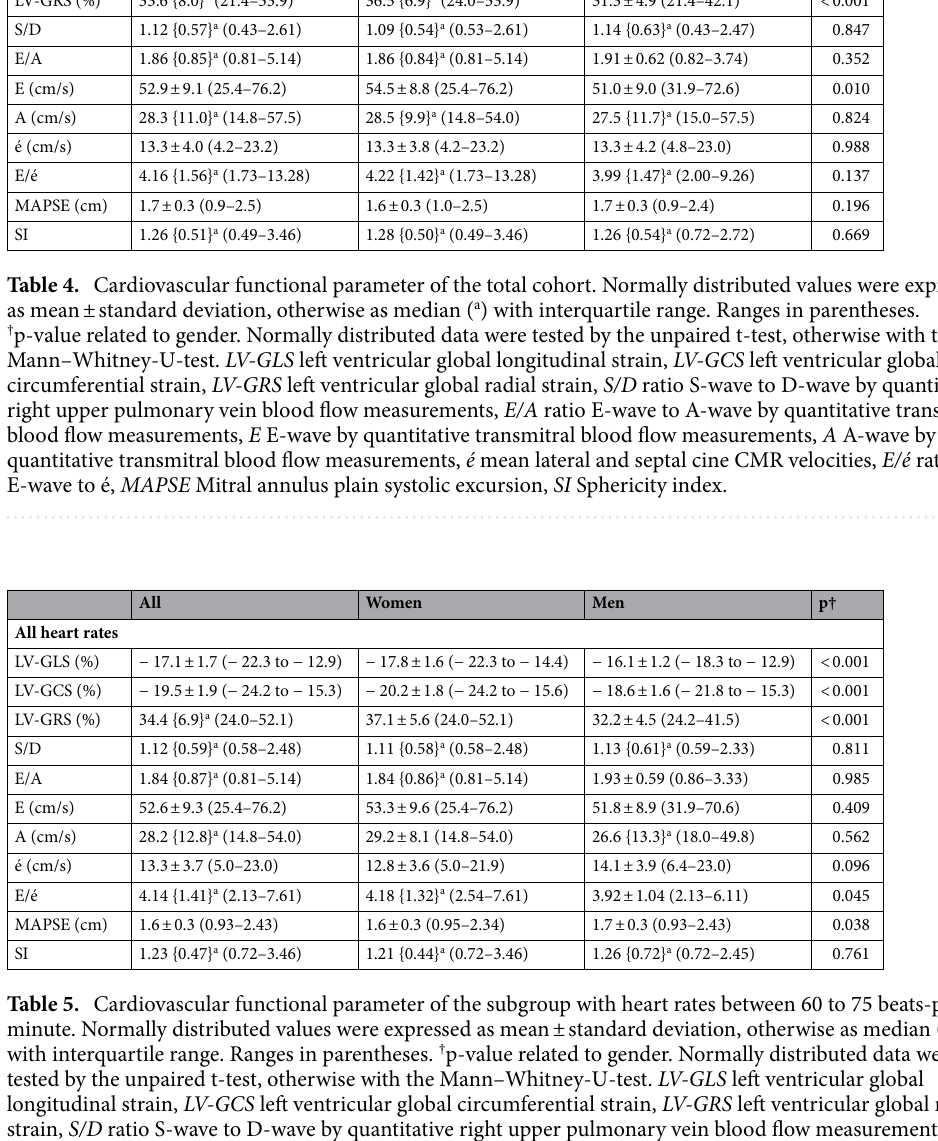
Multiple linear regression analyses. Multiple linear regression analyses derived from the bivariate cor- relation analyses are summarized in the Supplementary Tables S2a–d online. Individual cardiac parameters were selected for clustering based on their bivariate value in order to acquire a broad statistical overview of relevant parameters impacting left atrial strain (see also Fig. 4). Due to the demonstrated multifactorial influences of left atrial strain, clusters of selected parameters may better characterize strain function. Multiple linear regression analyses were performed for strain and strain rate of all subjects and subgroups with heart rates between 60 and 75 bpm.